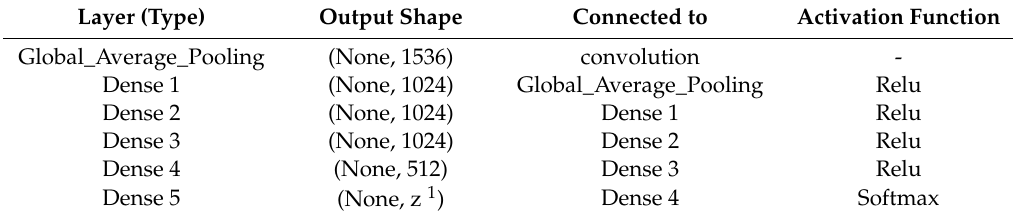
Table 1. The properties of Layers following InceptionResnetV2 base model.